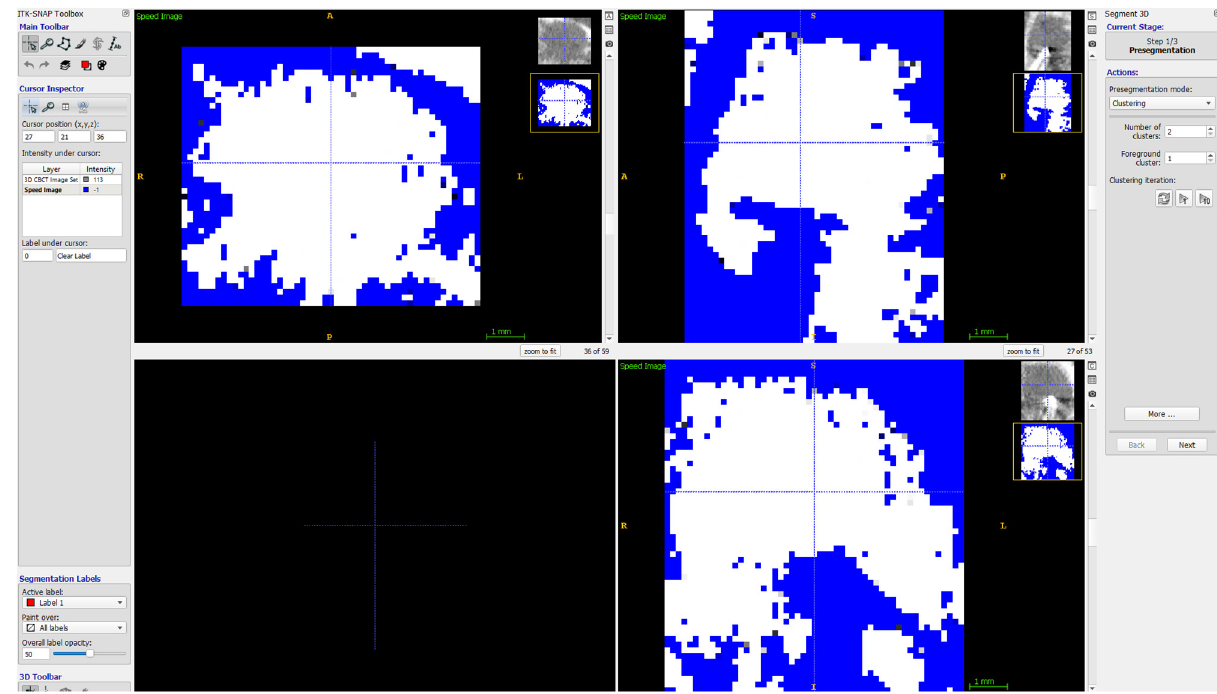
Figure 6. ITK-SNAP the view after semiautomatic defect recognition, before initiation of the semi- automatic algorithm using spherical fillers “bubbles”, filling the “white” area.